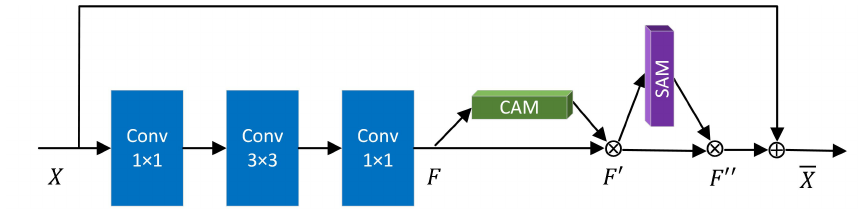
Figure 7. Improved residual